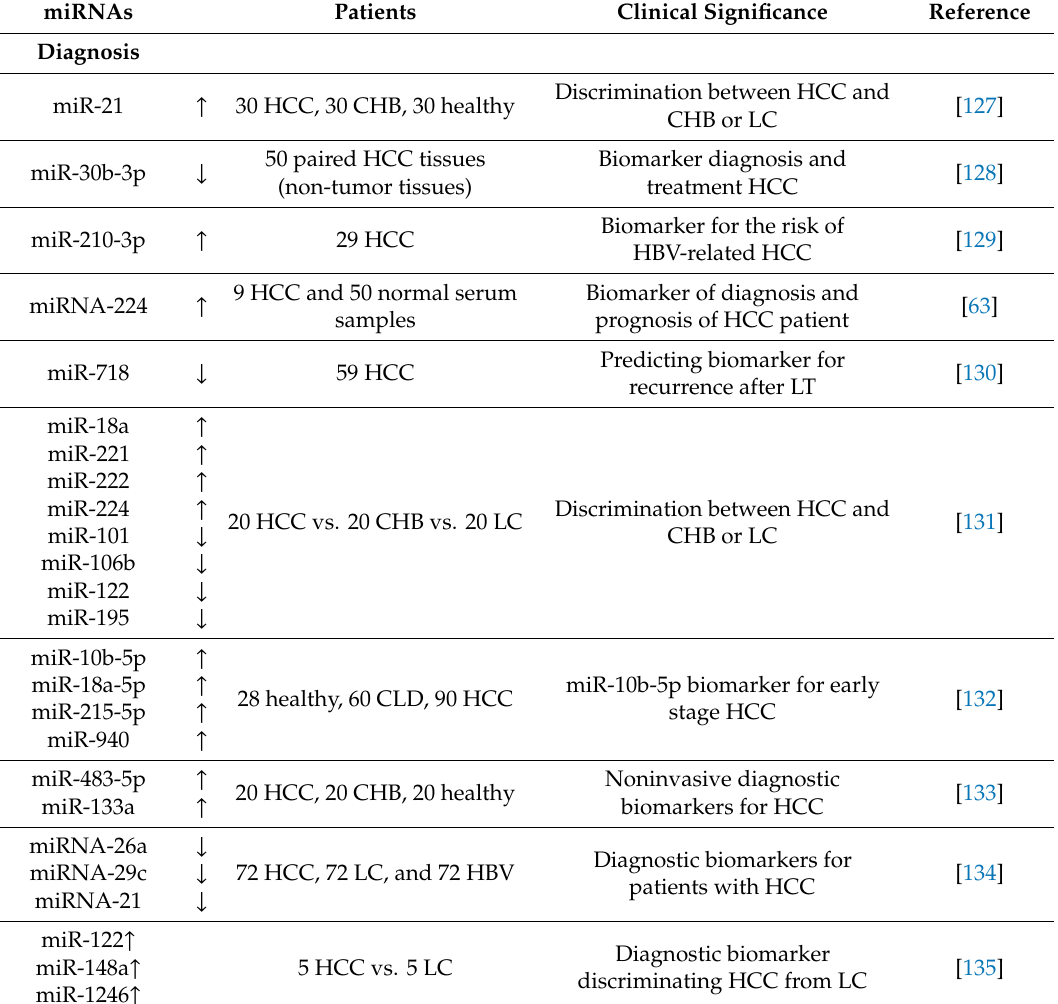
Table 2. miRNA as biomarkers for diagnosis of HCC.